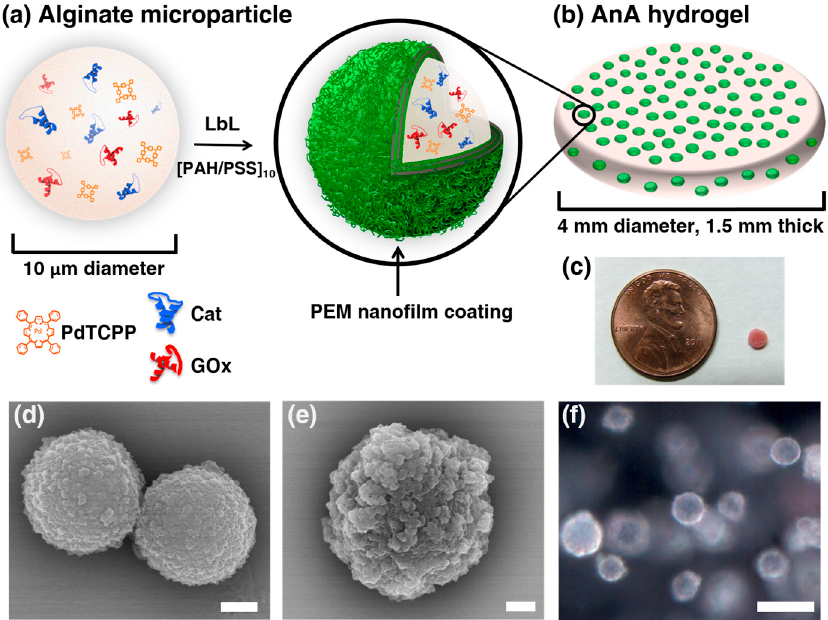
Figure 1. Alginate in alginate (AnA) hydrogels: composition and microscopic imaging. ( a ) Illustration of an alginate microparticle containing Pd-meso-tetra(4-carboxyphenyl) porphyrin (PdTCPP), glucose oxidase (GOx), and catalase (Cat) coated with 10 bilayers of poly(allylamine hydrochloride) (PAH) and poly(sodium-4-styrenesulfonate) (PSS); ( b ) AnA hydrogel with embedded polyelectrolyte multilayer (PEM) coated alginate particles; ( c ) Photograph of AnA hydrogel next to a penny; SEM micrograph of ( d ) uncoated and ( e ) coated alginate microparticles, respectively. Scale bars = 1 μ m for both micrographs; ( f ) Darkfield optical image of the AnA hydrogel containing alginate microparticles distributed throughout an alginate matrix. Scale bar = 10 μ m.